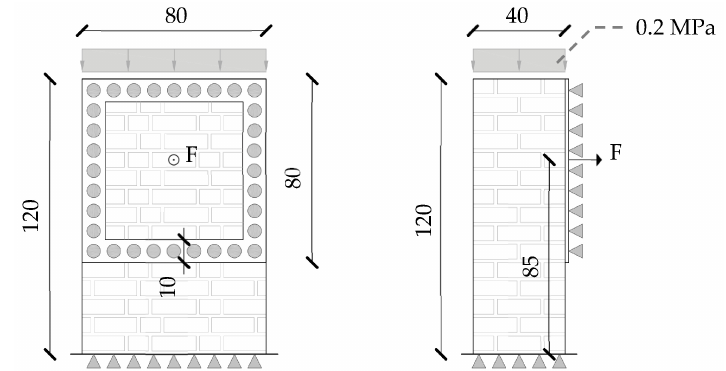
Figure 4. Geometry of the walls for pull-out tests (dimensions in cm).